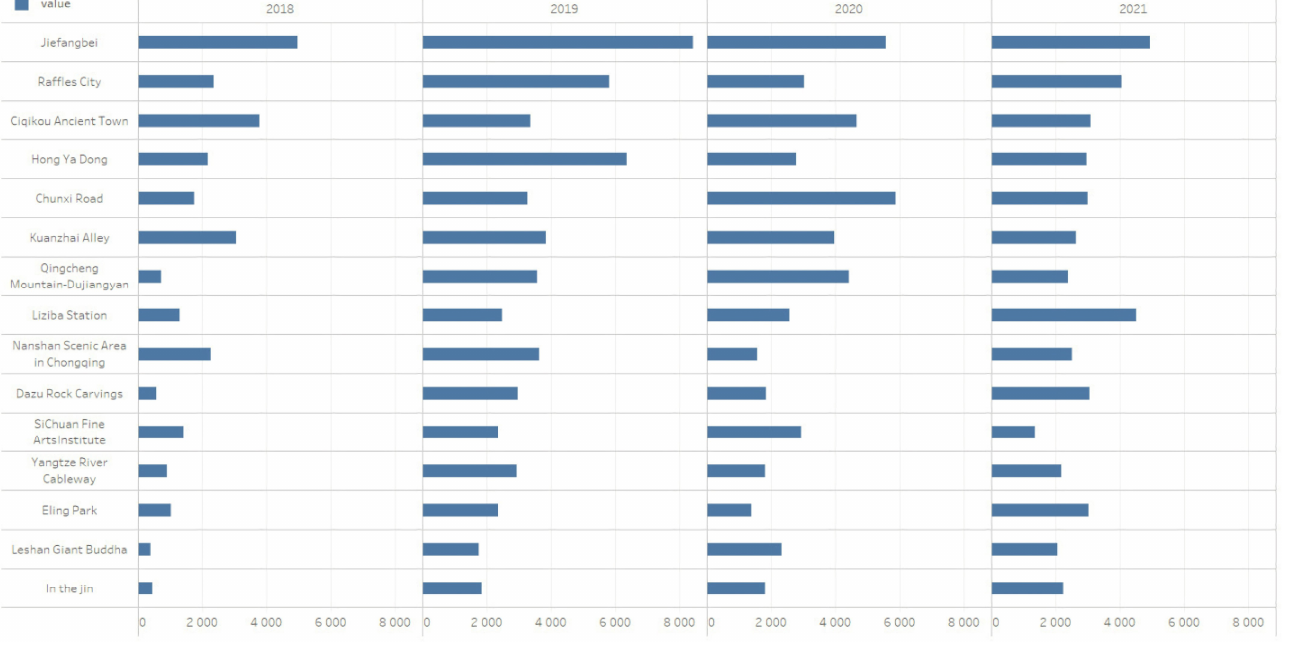
Figure 7. Betweenness centrality value of tourist attractions in the Chengdu–Chongqing Economic Circle in